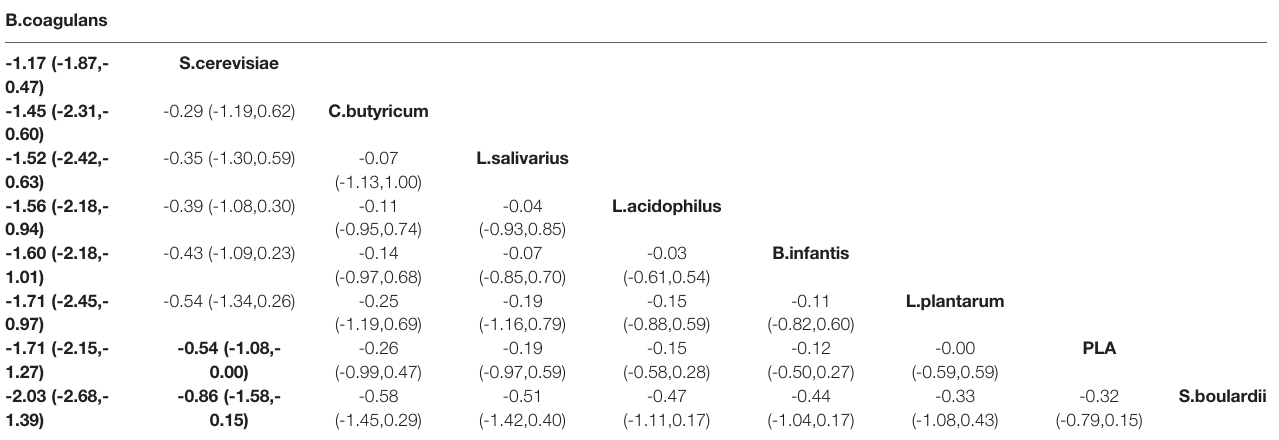
TABLE 4 | Standardized mean differences (SMDs) and 95% CI on abdominal pain scores.